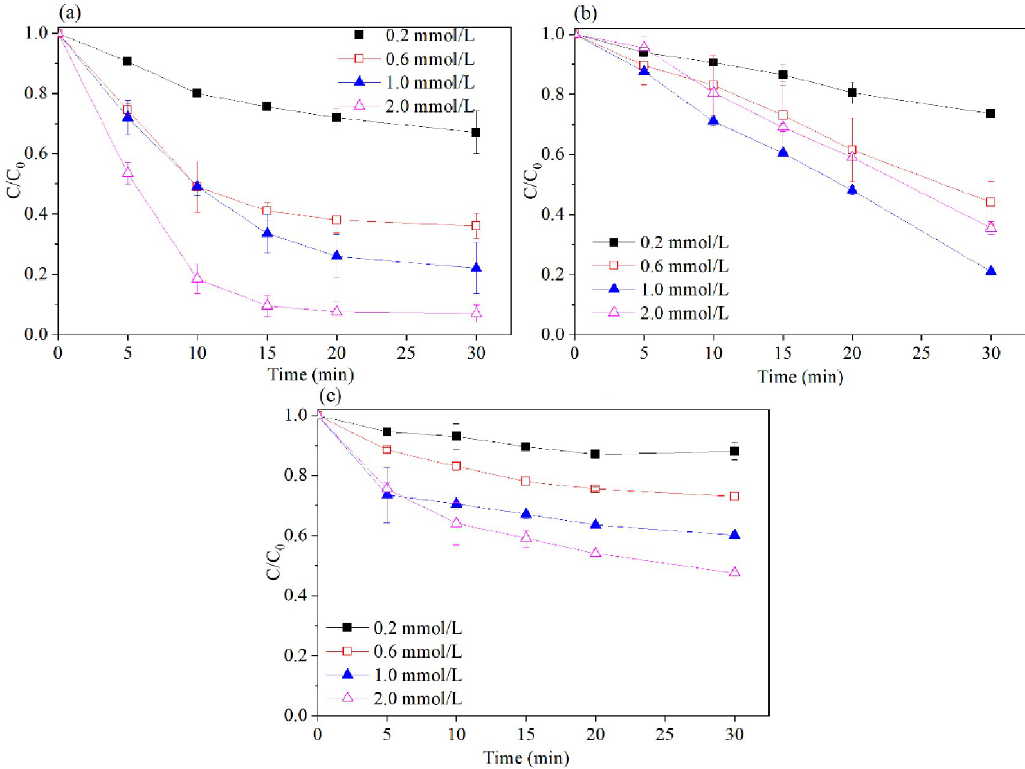
Fig 3. Effect of peroxides concentration on the degradation of 2,4,6-TCP in four systems. (a) Fe 0 /H 2 O 2 ; (b) Fe 0 /PMS; (c) Fe 0 / PS. Conditions: c(2,4,6-TCP) = 0.2 mmol•L -1 ; c(Fe 0 ) = 0.1 g/L; pH = 3.2 ± 0.05.